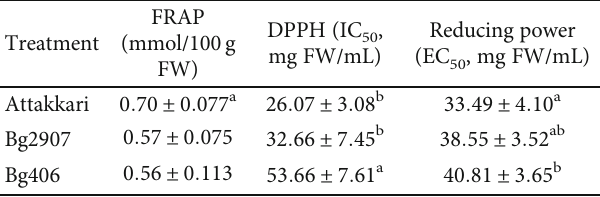
Table 1: Total antioxidant capacities measured by ferric reducing antioxidant power, DPPH radical scavenging capacity, and reducing